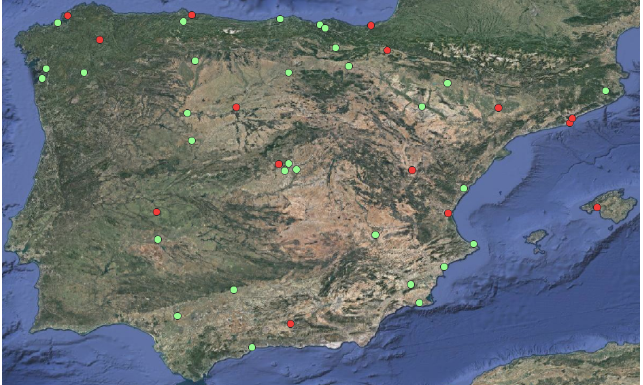
Figure 4. Data-set geographical distribution (green train set/red test